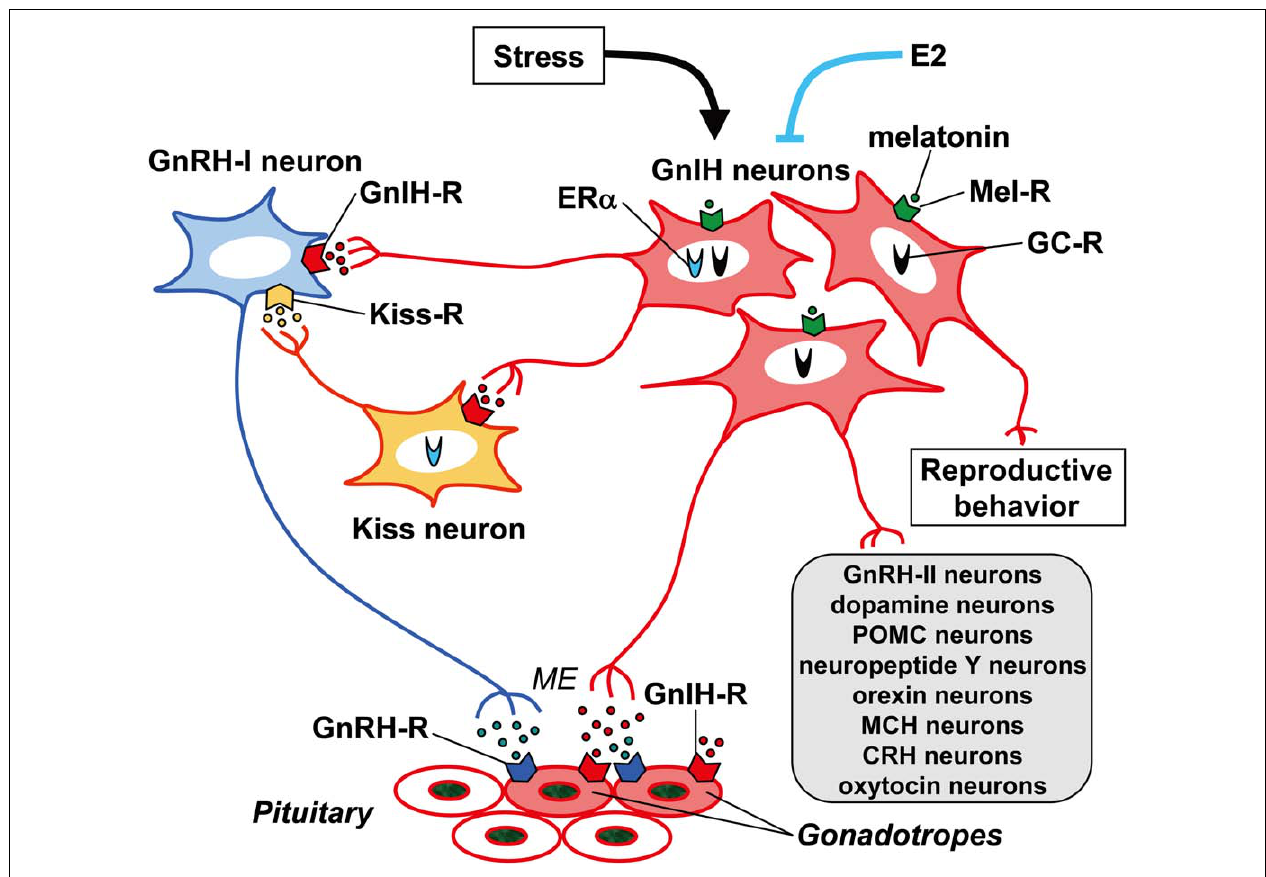
FIGURE 3 | Schematic model of GnIH (RFRP) action in the brain and pituitary. GnIH (RFRP) neurons in the brain project their axons to GnRH-I neurons as well as to the median eminence (ME). GnIH receptor (GnIH-R; GPR147) is expressed on GnRH-I neurons as well as gonadotropes. GnIH may thus inhibit gonadotropin synthesis and release by inhibiting the activity of GnRH-I neurons as well as directly inhibiting the pituitary gonadotrope. GnIH (RFRP) neurons may also regulate GnRH-I neurons by regulating the activity of kisspeptin (Kiss) neurons that project to GnRH-I neurons.There are also reports showing that GnIH (RFRP) neurons project their axons to GnRH-II, dopamine, pro-opiomelanocortin (POMC),